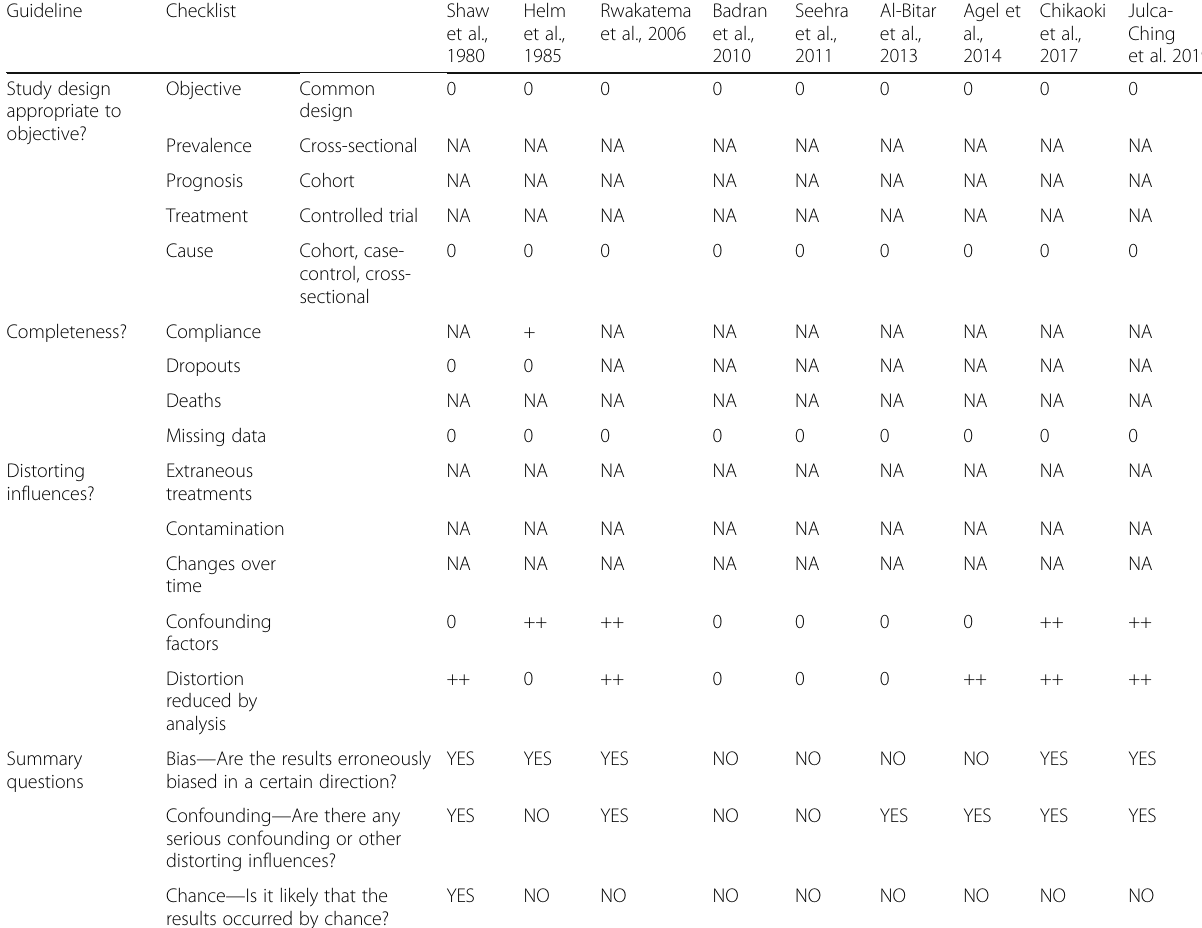
Table 4 Results of methodological quality assessment of included studies, according to Fowkes and Fulton criteria